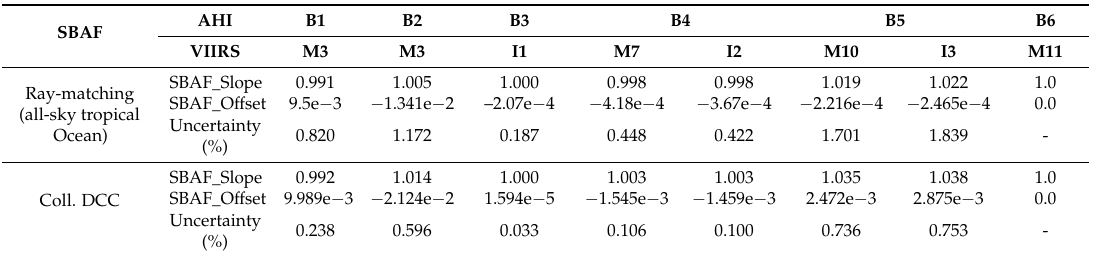
Table 2. SBAF (AHI/VIIRS) coefficients (slope and offset) for AHI VNIR bands and the uncertainty values.